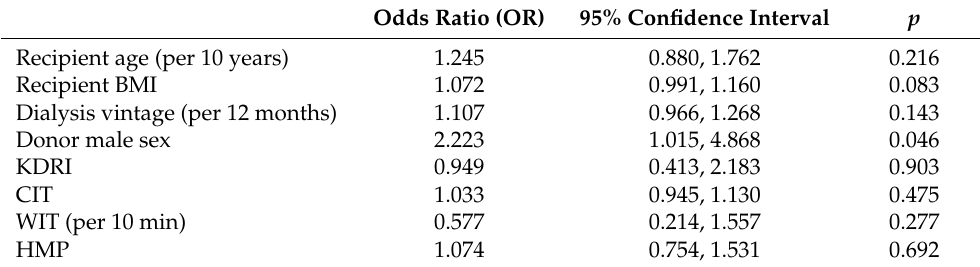
Table 4. Results from multivariable logistic regression analysis of risk factors independently associ- ated with delayed graft function.